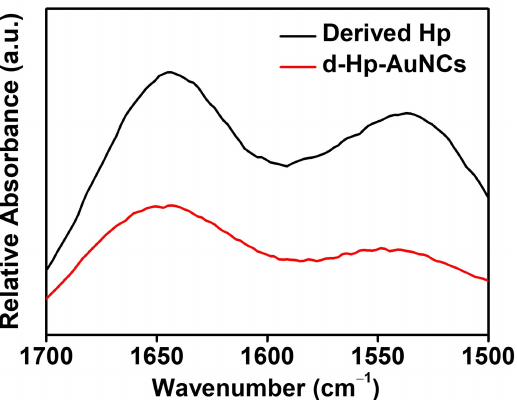
Figure 3. FTIR spectra of the derived haptoglobin (Hp) peptide and derived Hp-conjugated gold nanoclusters (d-Hp-AuNCs).